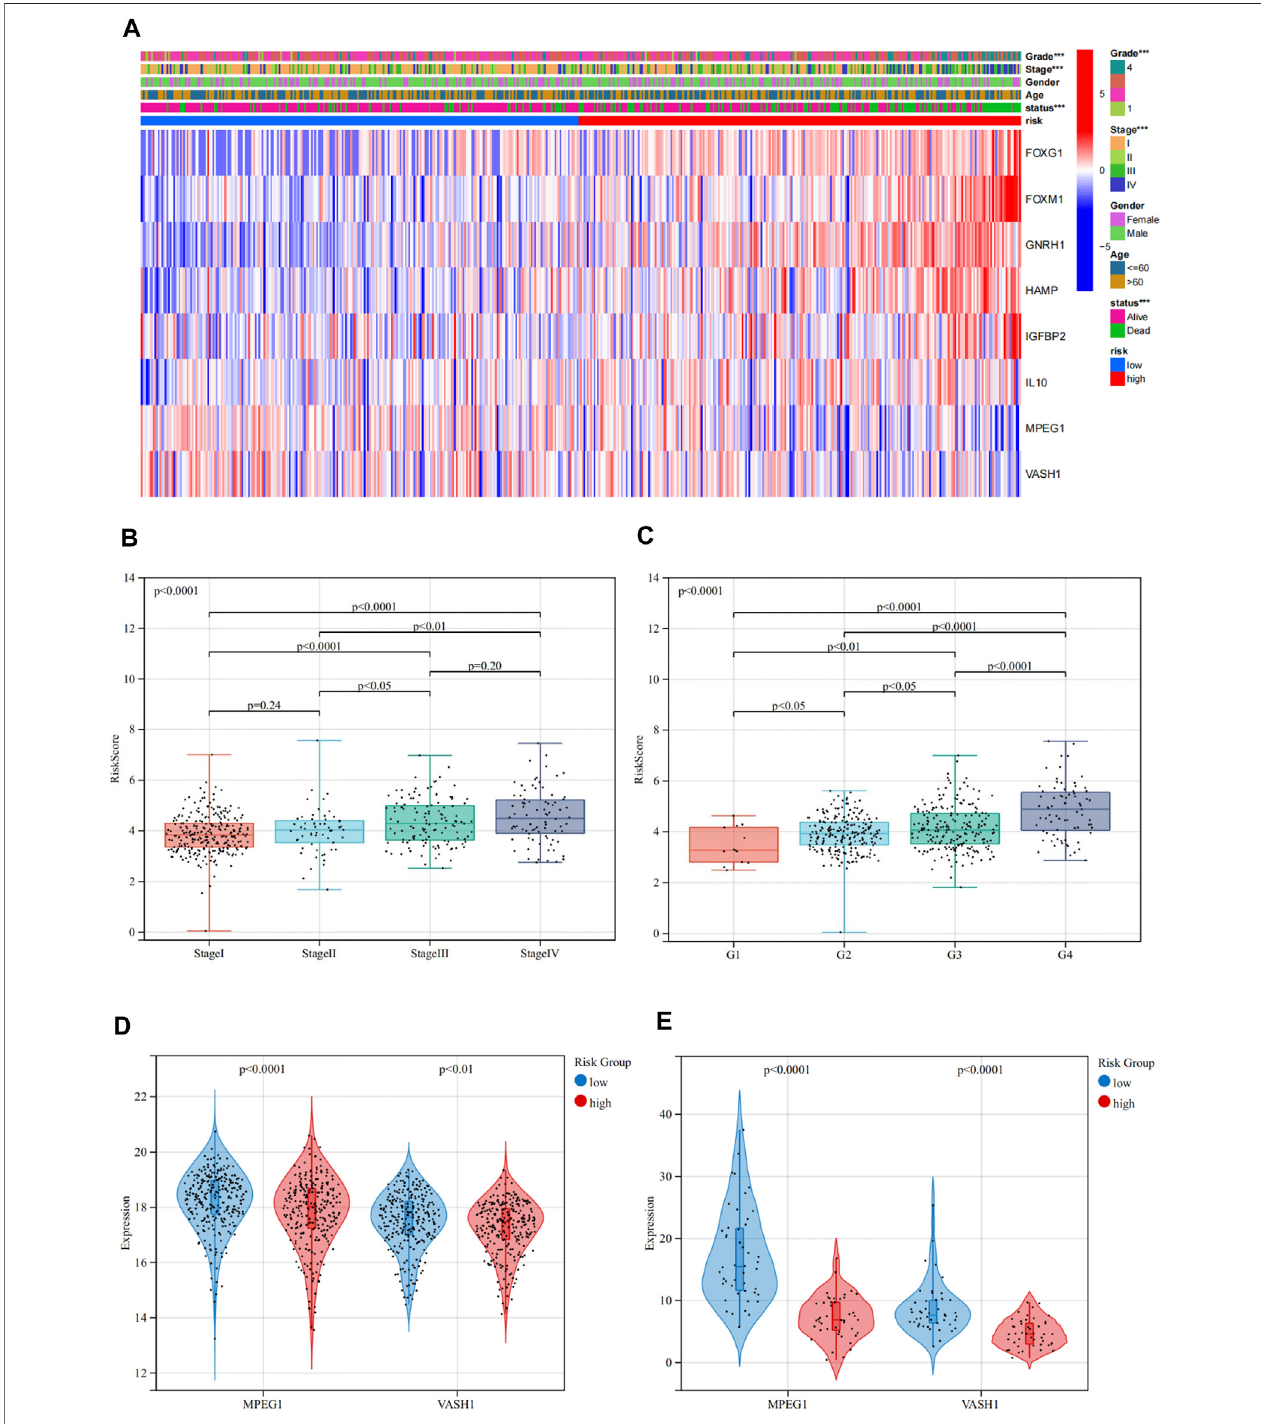
FIGURE 4 | Relationship between the risk groups and clinicopathological features in TCGA. (A) Heat map depicting the prognostic signature and clinicopathological features of ASRGs. (B,C) Relationship between risk scores and the AJCC stage and pathological grade. (D,E) Expression levels of MPEG1 and VASH1 in low- and high-risk groups in TCGA and ICGC